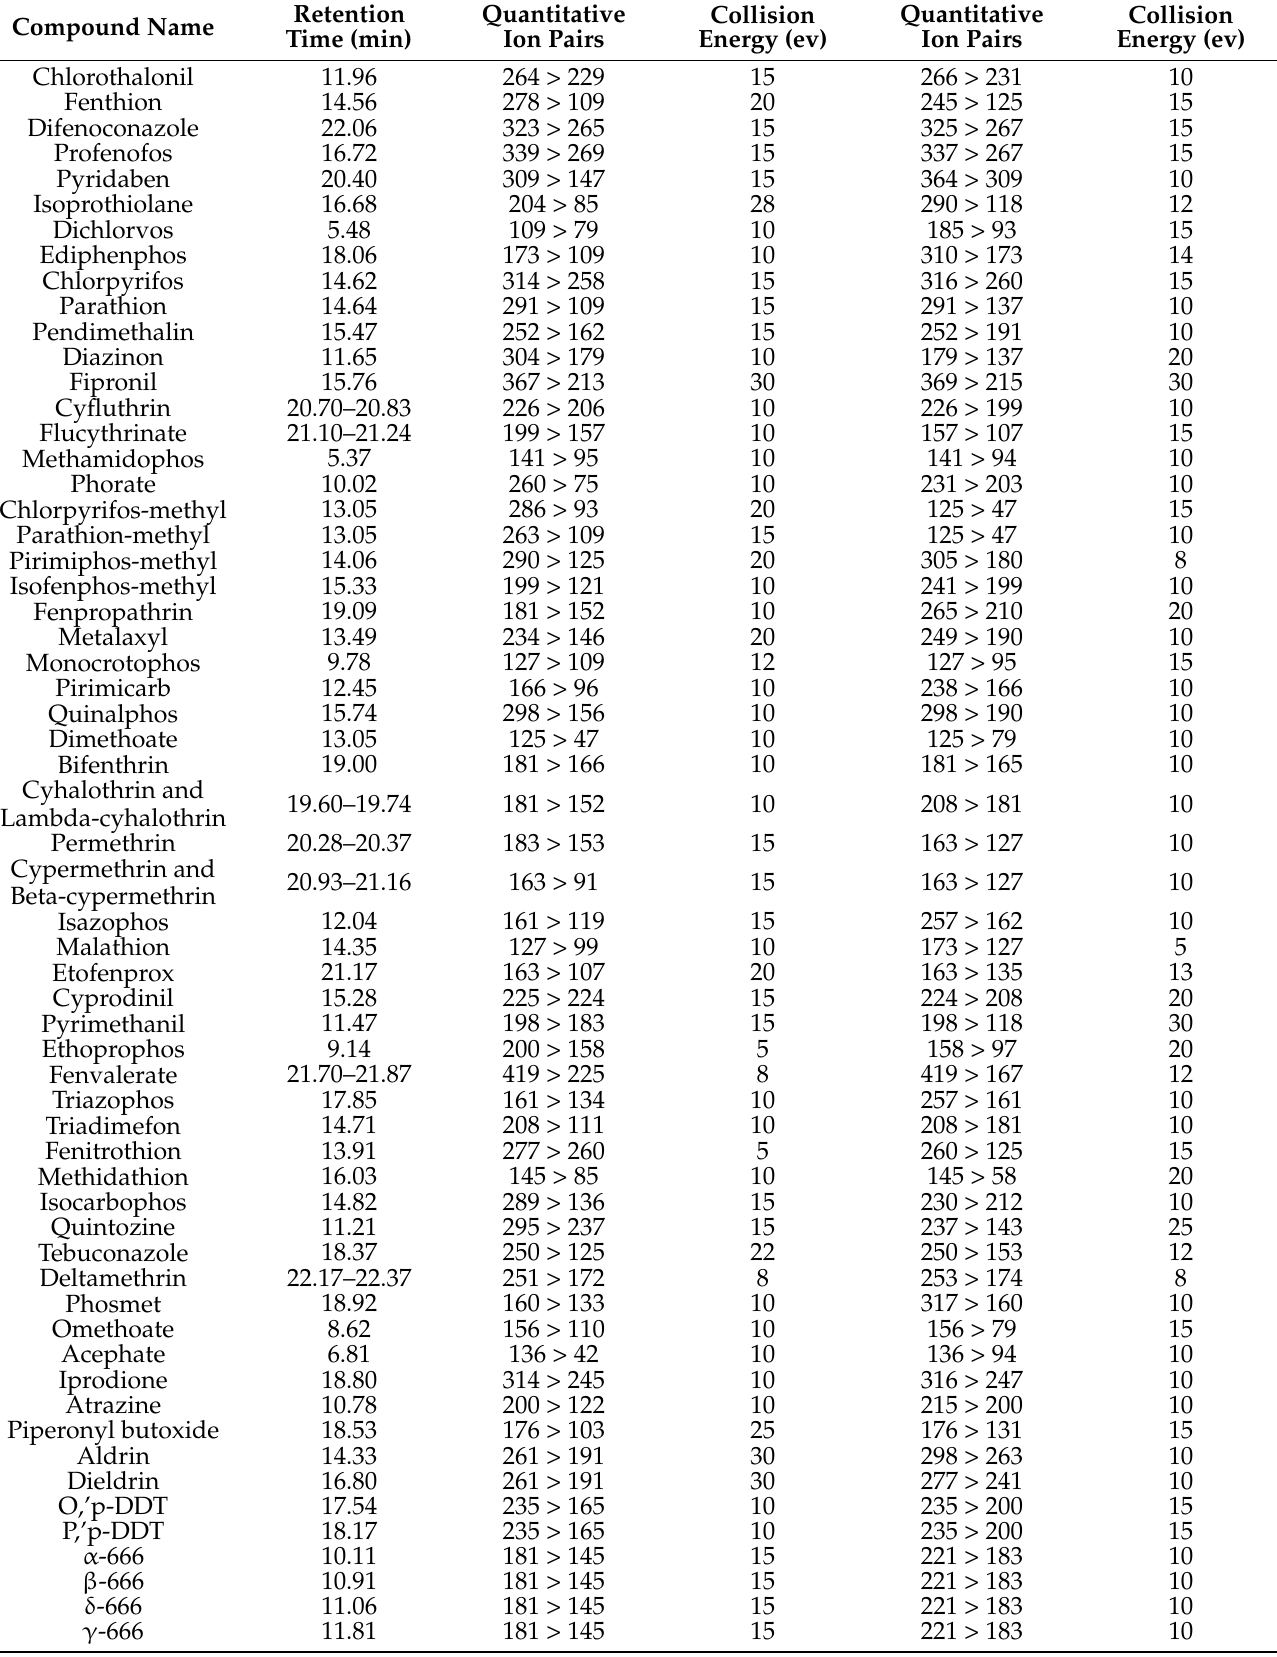
Table A2. GC-MS/MS parameters optimized for determination of 60 pesticide